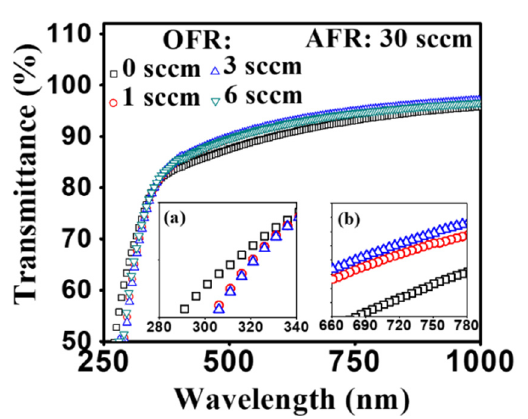
Figure 4. Optical transmission spectra of radio frequency (RF) sputtered a -IGZO films on clean bare glass with di ff erent O 2 flow rates during film growth. Subfigures are shown for the variation of transmittance at ( a ) shorter and ( b ) longer wavelength range.